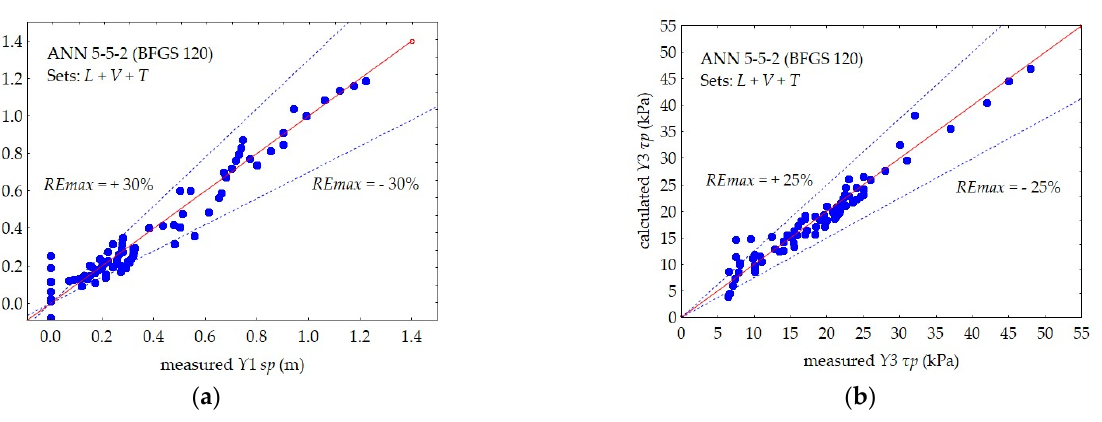
Figure 11. Comparison between the measured and calculated values by ANN 5–5–2 in subsets L + V + T for peat: ( a ) Y 1 sp , ( b ) Y 3 τ p .